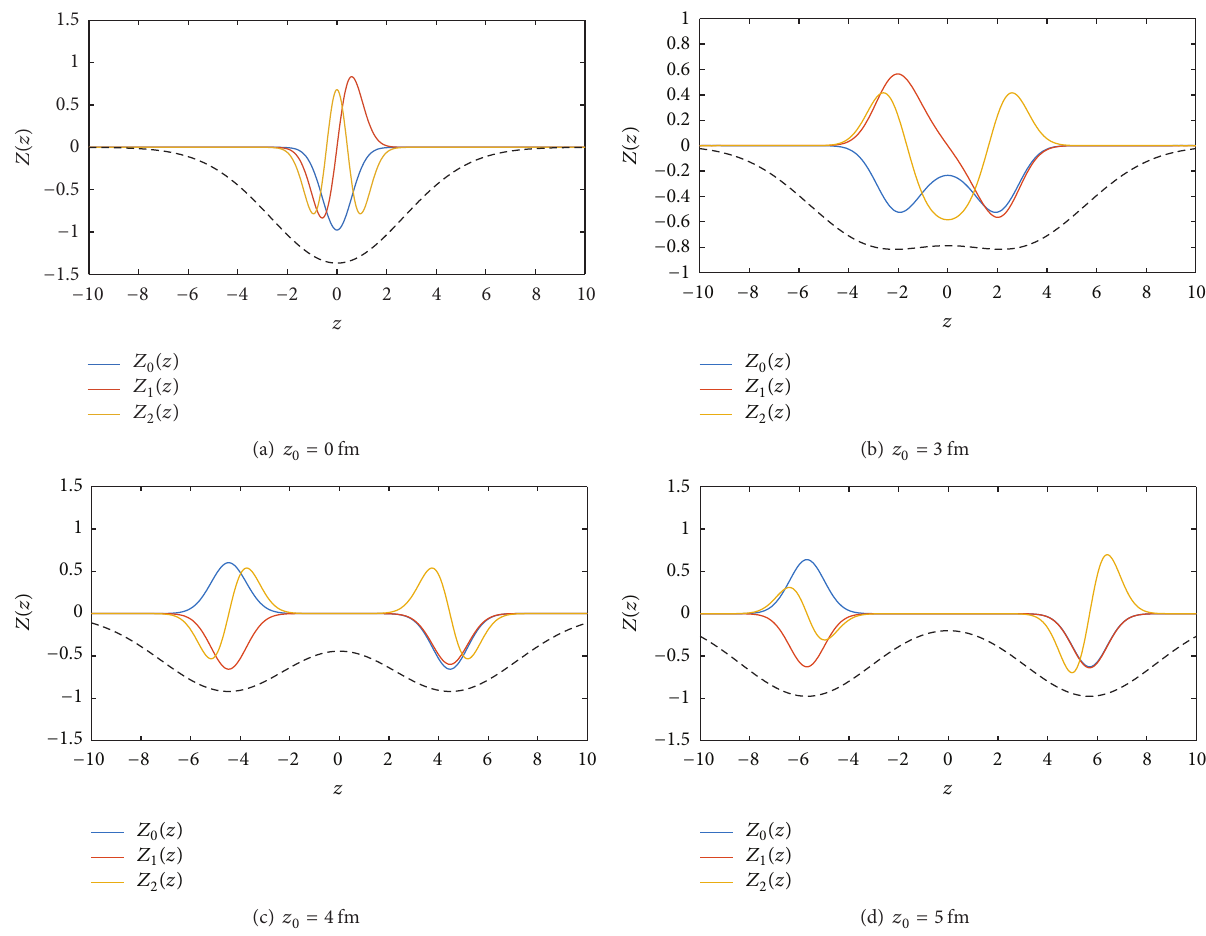
Figure 4: The eigenvectors 𝑍(𝑧) of three lowest states for some values of 𝑧 0 .